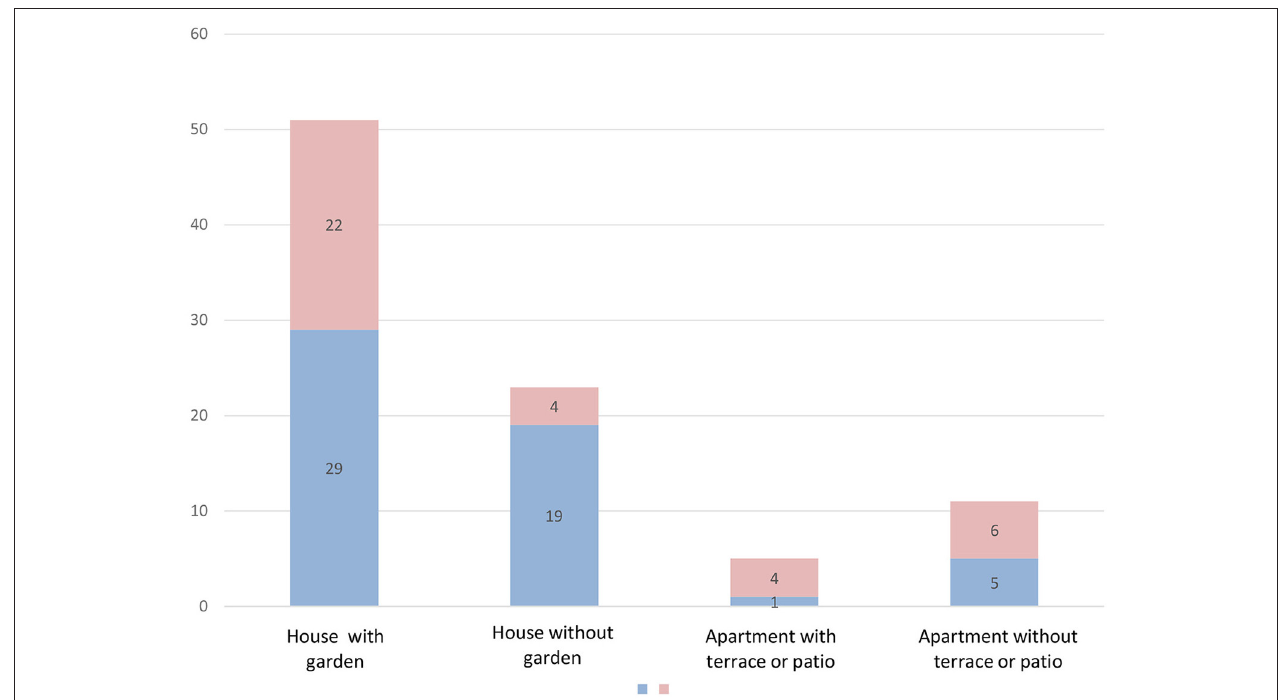
FIGURE 2 | Type of living place-behavioral